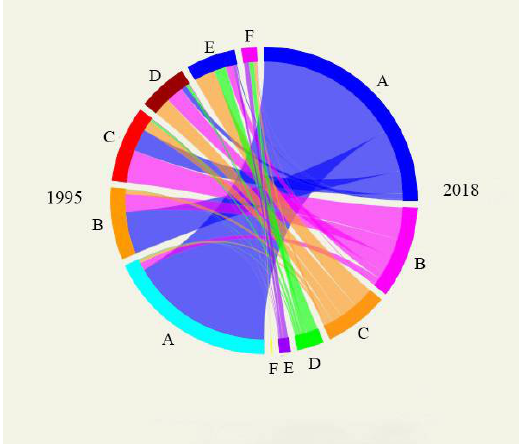
Figure 9. Chordal graph of soil erosion intensity in South and North Mountains of Lanzhou from 1995 to 2018 (Note: A: slight erosion; B: mild erosion; C: moderate erosion; D: strong erosion; E: extremely strong erosion; F: severe erosion).